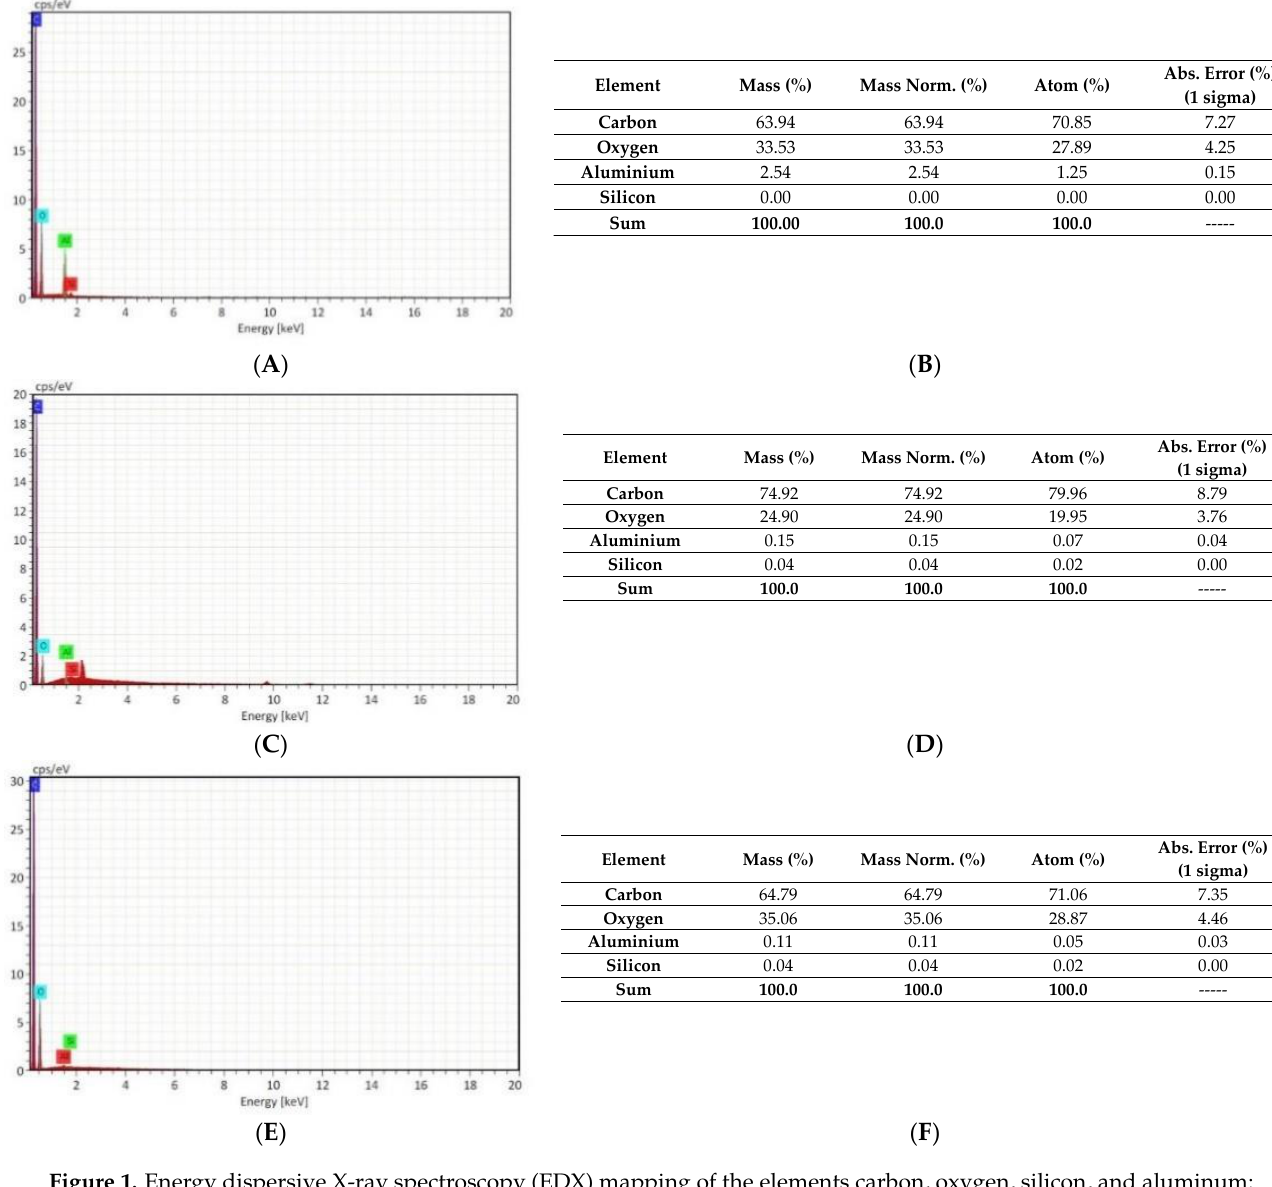
Table 2. Morphological characteristics of the fibers.